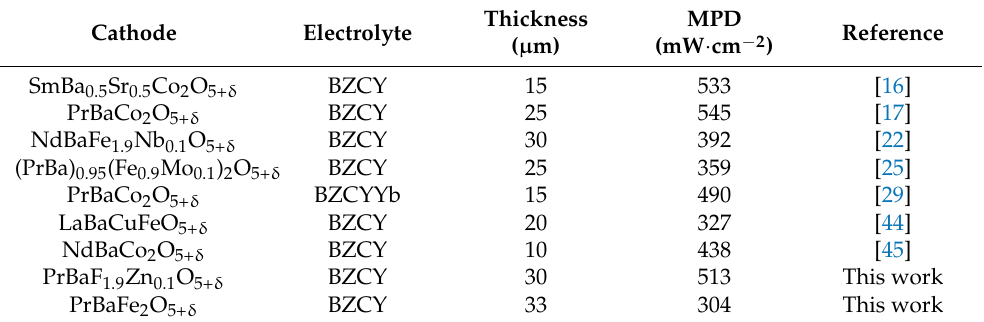
Table 1. Lists of peak power densities (PPDs) for previously reported proton-conducting SOFC using layered double perovskite as a cathode at 700 ◦